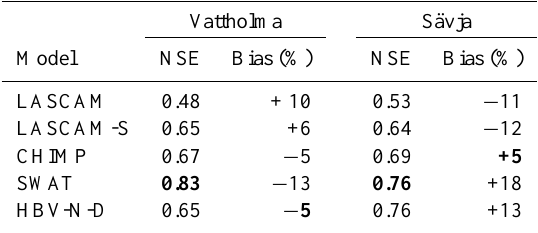
Table 2. Overview of the adopted merging schemes for ensemble generation. Merging scheme Description Abbreviation Mean Daily mean of the predictions ME Weighted mean Daily weighted mean of the predictions a . WM Median Daily median value of the prediction MD Un-constrained multiple linear regression Observations are used as dependent variables while predictions are used as UR independent ones. Constrained multiple linear regression Same as above with an interception constrained through CR the origin a Weights are set at the objective function value for R 2 , but its inverse for RMSE.